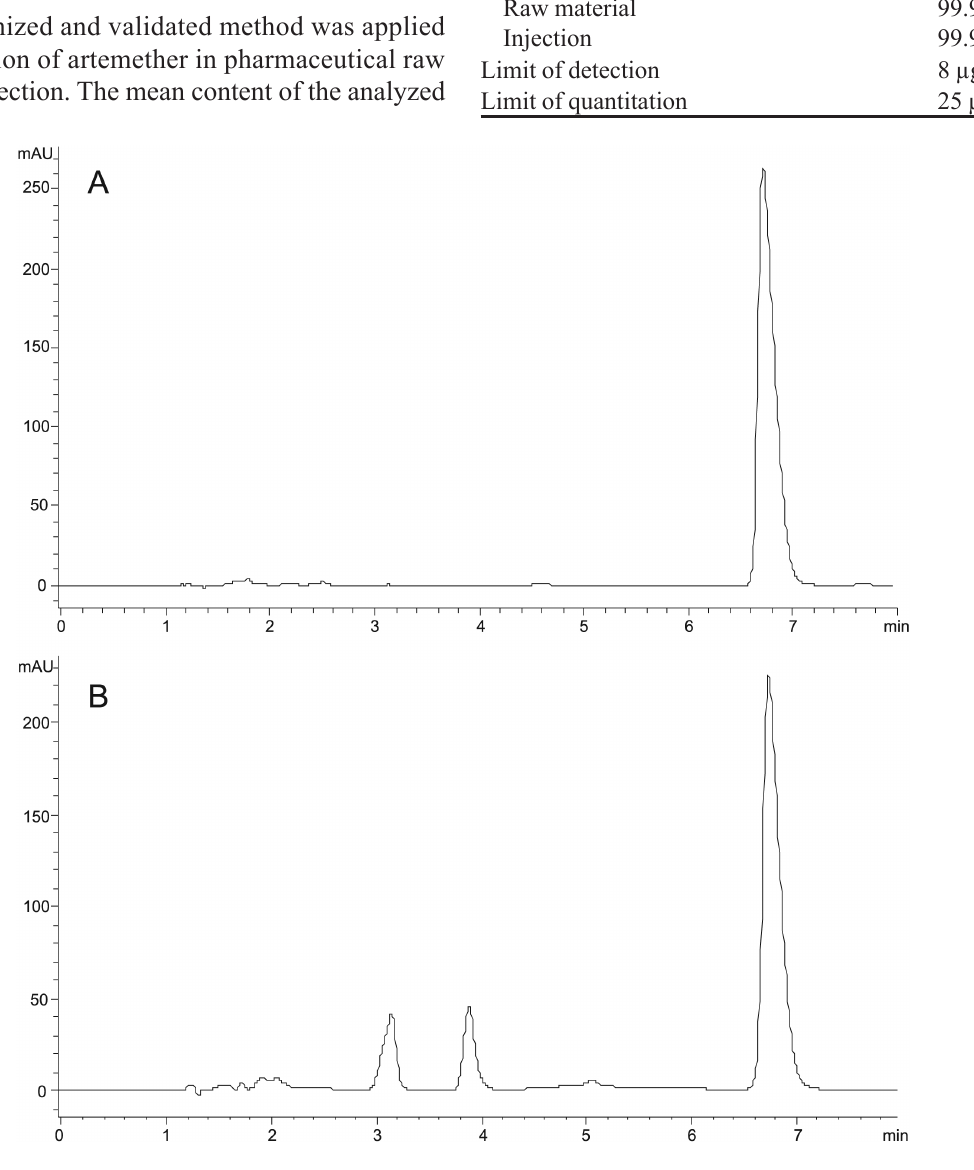
(150 x 4.6 mm, 5 µm) column, at 30 °C, mobile phase composed of FIGURE 3 – HPLC chromatograms obtained in a Zorbax C 18 acetonitrile and water (70:30), flow rate of 1mL/min and detection at 216 nm. Samples of artemether: (A) raw material; (B)